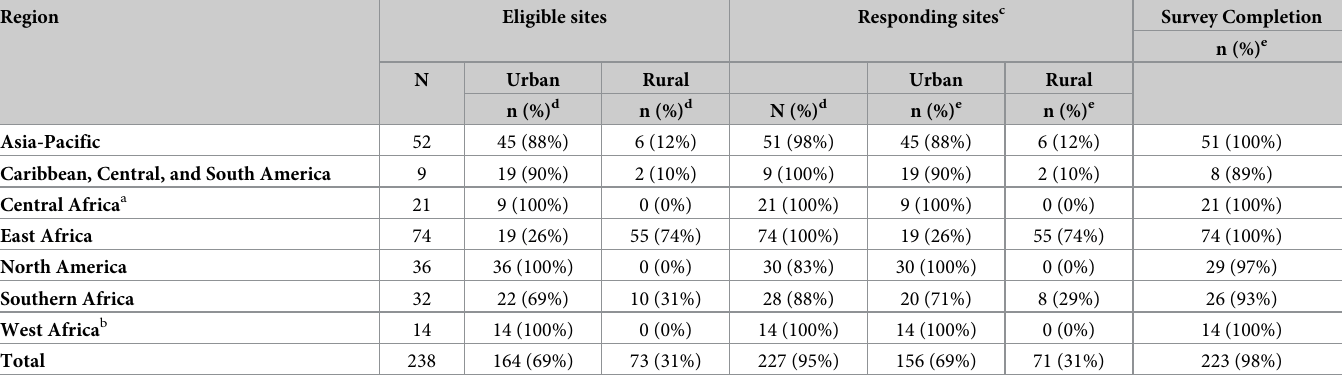
Table 1. 2020 IeDEA-wide site assessment survey response and completion rates. Region Eligible